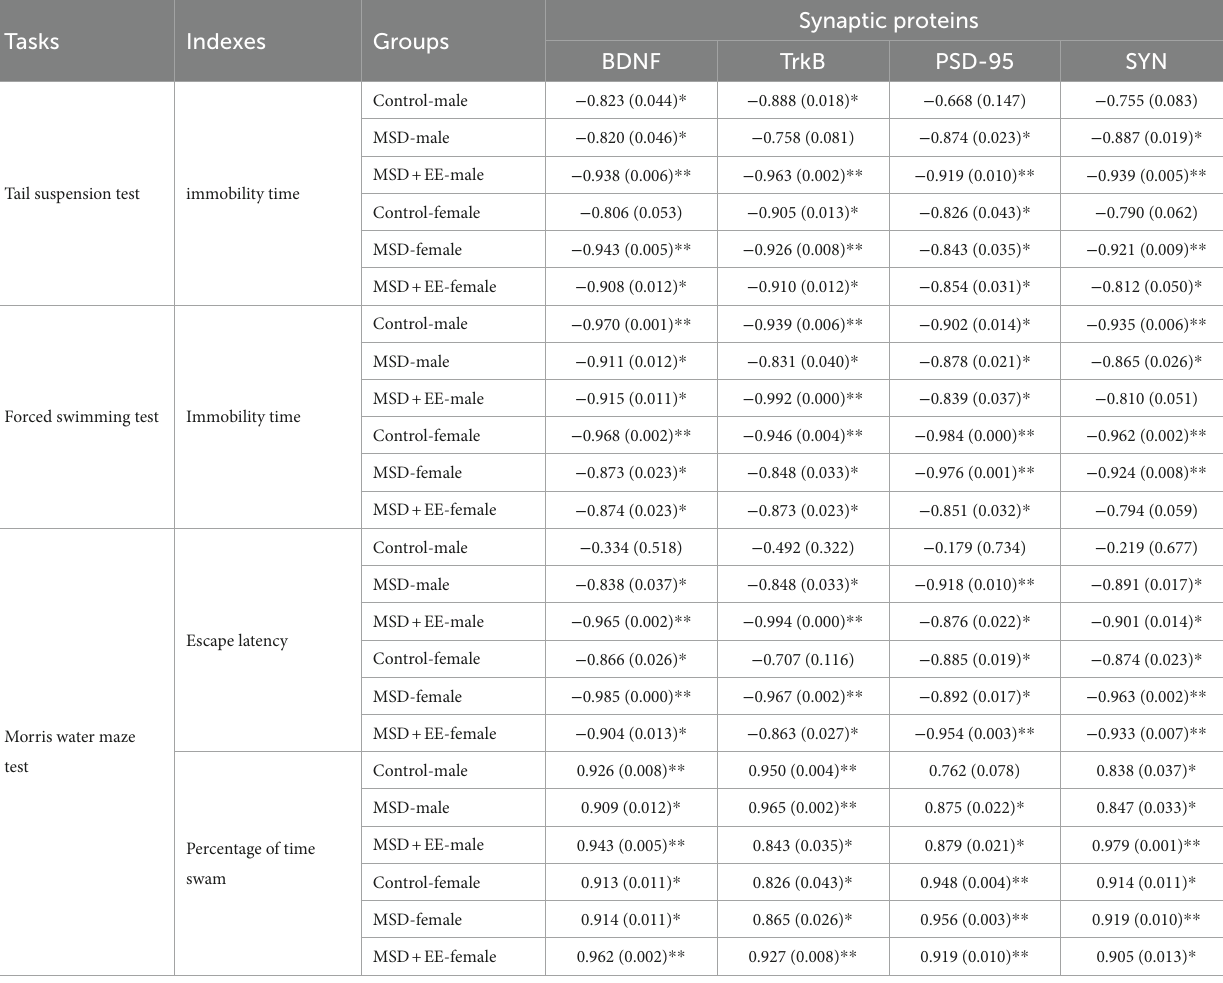
TABLE 2 Correlations between depression/cognition-related tasks and hippocampal synaptic plasticity-associated proteins.